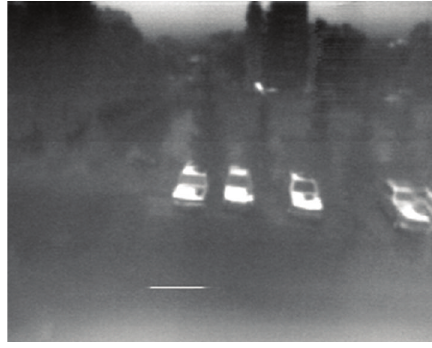
Figure 10: KUT28 WSS starting image.